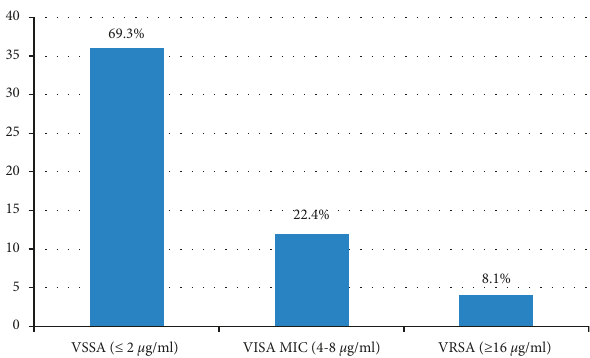
Figure 1: MIC results of vancomycin against MRSA